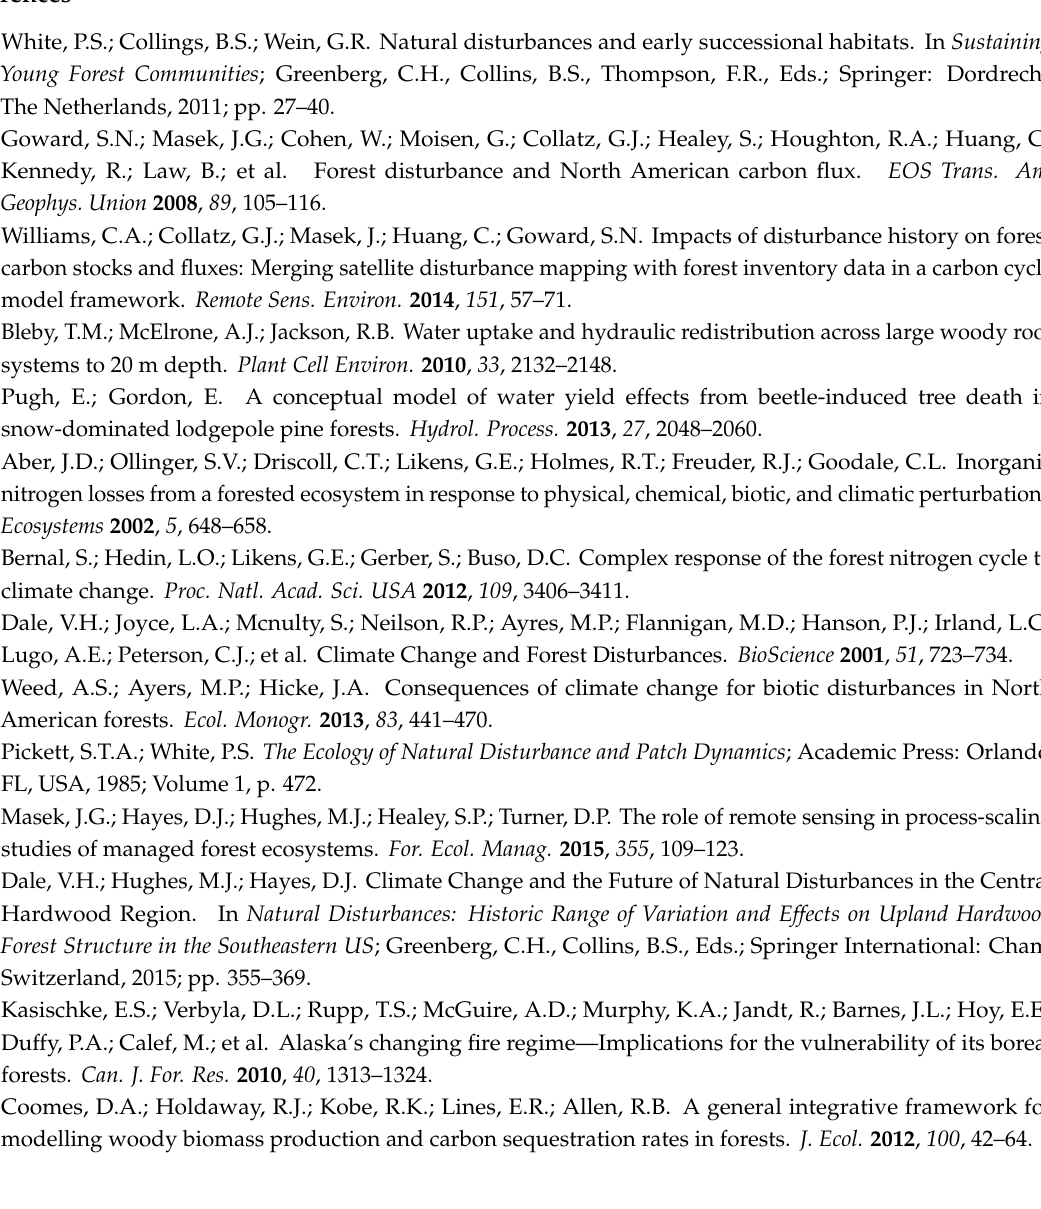
Figure S1: Kappa by β , the ratio between vegetation index and years, Figure S2: Kappa by θ , the angle threshold for temporal